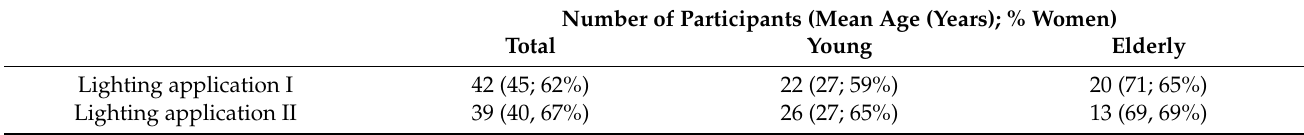
Table 1. Number of participants, mean age and gender